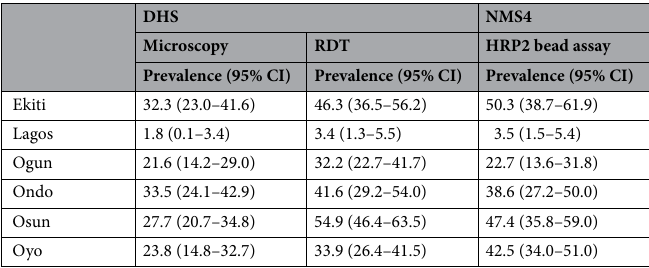
Table 1. Weighted malaria prevalence estimates and 95% confidence intervals between DHS and NMS4 by demographic and geographic variables among 6–59-month-old children in Nigeria, 2018. DHS Demographic